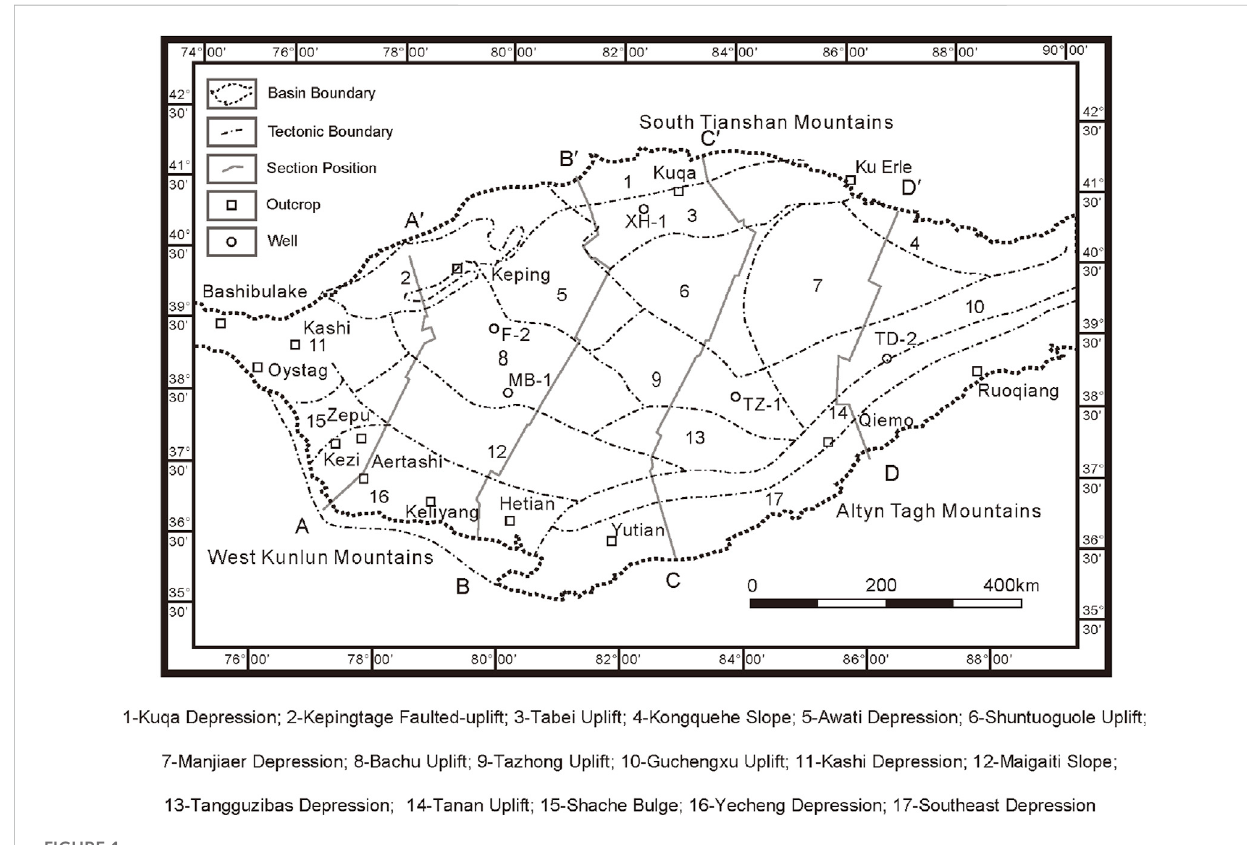
FIGURE 1 Schematic structural map of the Tarim Basin (modi fi ed after He et al., 2016; Laborde et al.,